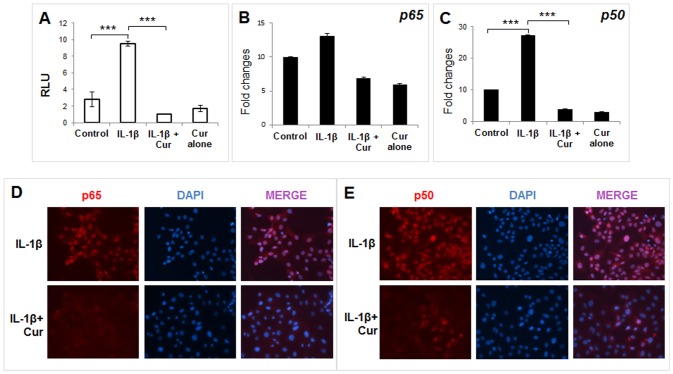
Transcriptional repression of IL-6 and regulation of NF-κB by curcumin.UIII and HuF cells were transfected with an IL-6 promoter reporter construct spanning -276 to +20 bp region. Cells were then treated with vehicle (control), IL-1β (10ng/ml), or with a combination of IL-1β (10ng/ml) and 30μM curcumin, or curcumin alone for 24hr. (A) IL-6 promoter activity was measured by dual luciferase assay in UIII cell lysates and normalized to Renilla. (B, C) Expression of p65 and p50 subunits of NF-κB was analyzed in HuF cells by qPCR. The values are expressed as the means ± S.E. (n = 3). ***, p < 0.001. (D, E) UIII cells were treated with IL-1β (10ng/ml), or with a combination of IL-1β and curcumin (30μM) for 24 hr. Cells were fixed in paraformaldehyde and processed for immunocytochemistry to analyze p65 and p50 NF-κB cellular localization. Red, p65/p50; blue, DAPI.